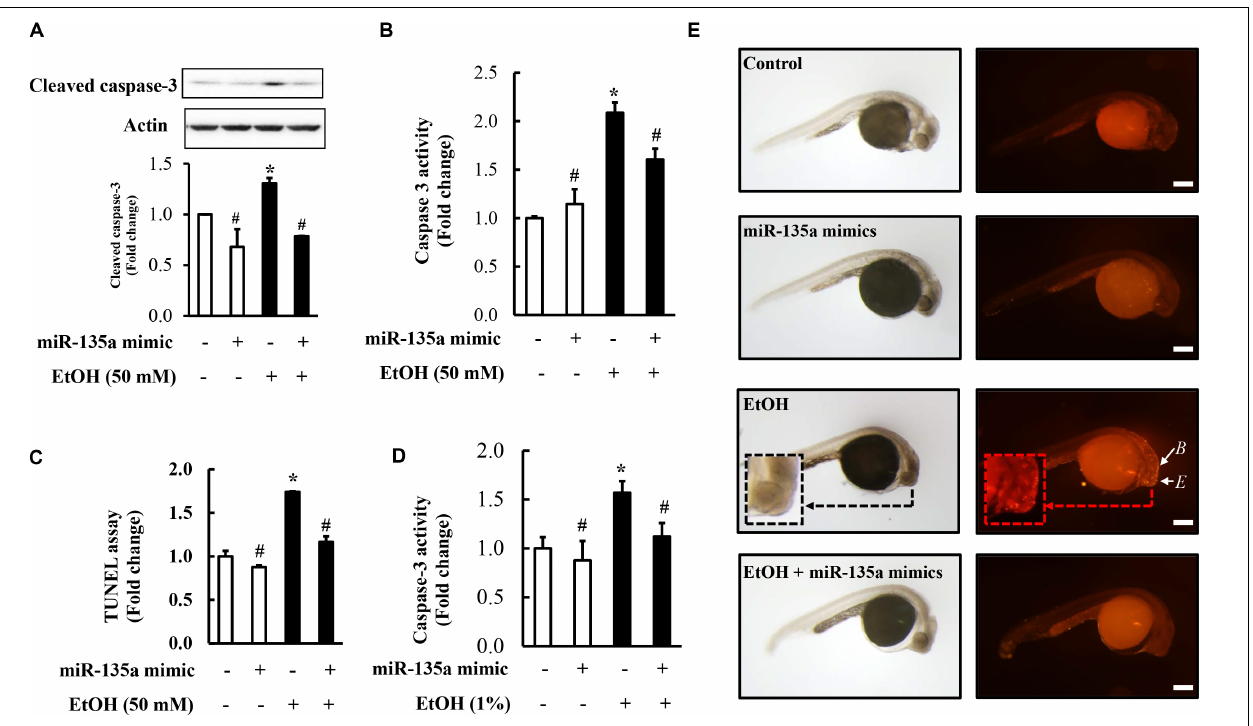
FIGURE 5 | Overexpression of miR-135a significantly decreased ethanol-induced caspase-3 activation and apoptosis in neural crest cells (NCCs) and zebrafish embryos. NCCs transfected with control mimics or miR-135a mimics were treated with 50 mM ethanol for 24 h. Zebrafish embryos microinjected with control or miR-135a mimics were treated with 1% ethanol and collected at 24 h post-fertilization (hpf). Ethanol-induced apoptosis in NCCs (A-C) and zebrafish embryos (D,E) was determined by analysis of caspase-3 cleavage (A) , caspase-3 activity (B,D) , and terminal deoxynucleotidyl transferase dUTP nick end labeling (TUNEL) analysis (C,E). White arrows in (E) indicate brain (B) and eye (E) in zebrafish embryos. Data are expressed as fold change over control and represent the mean ± SD of three separate experiments. * p < 0.05 vs. control; # p < 0.05 vs. ethanol. Scale bar = 200 µ